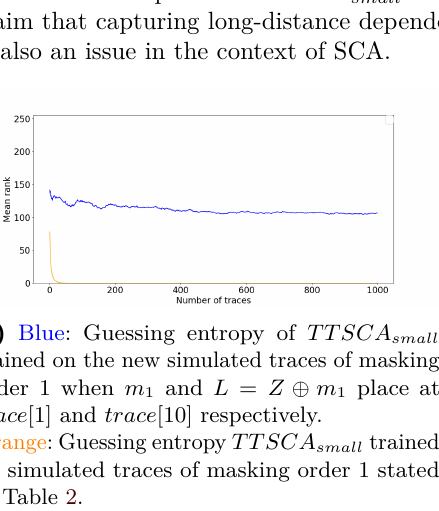
Figure 6: Guessing entropy of TTSCA small trained on new simulated traces and a visualization of the new simulated trace with masking order